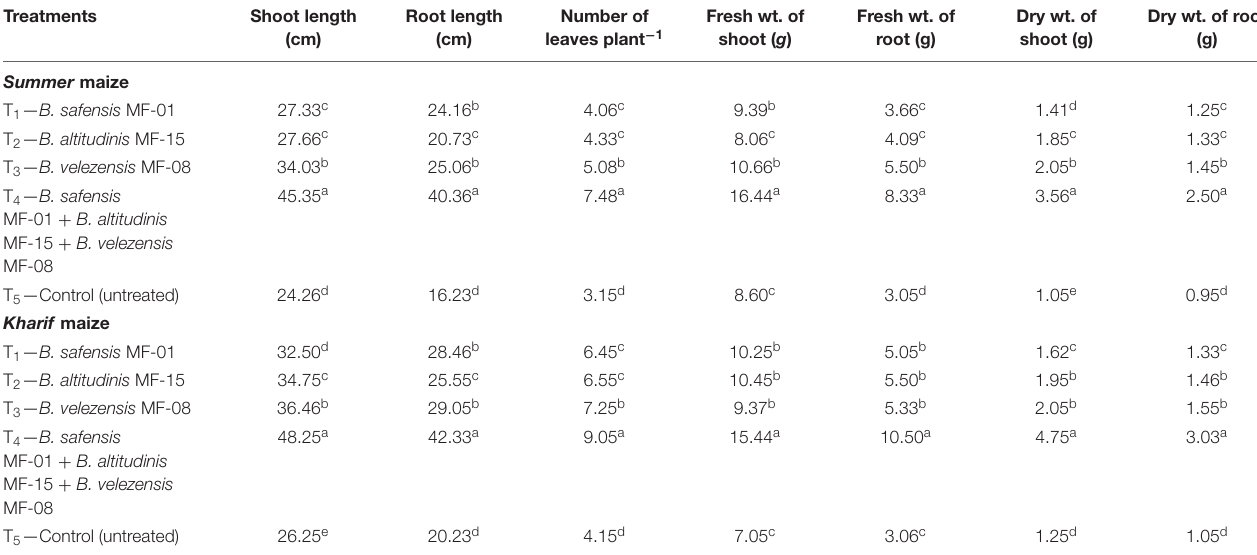
TABLE 4 | Effects of seed biopriming and microbial intervention on plant growth parameters in maize grown in Summer and Kharif season under nethouse experiments at 45 days of sowing. Treatments Shoot length